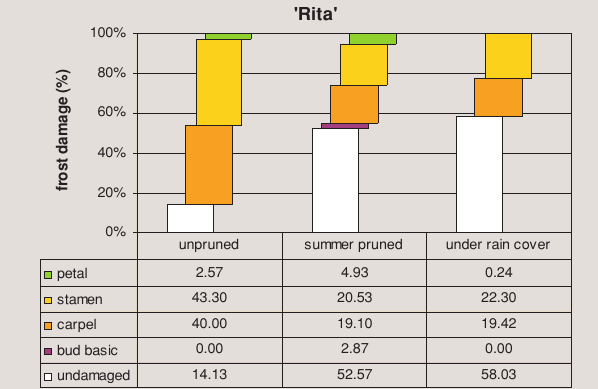
Figure 3. Frost damage in buds of the variety ’Rita’ observed on trees in